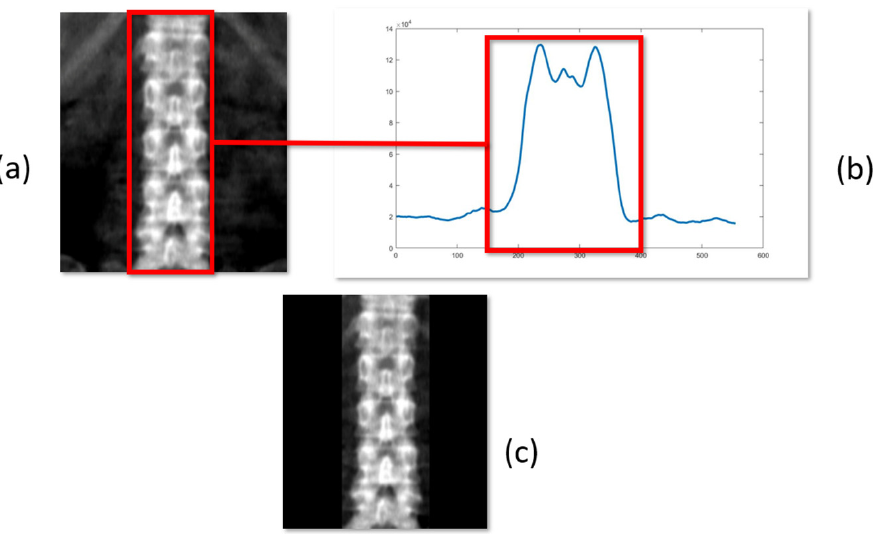
Figure 6. Original Input image ( a ) vertical projection graph ( b ) and result of spine cropping ( c ) .